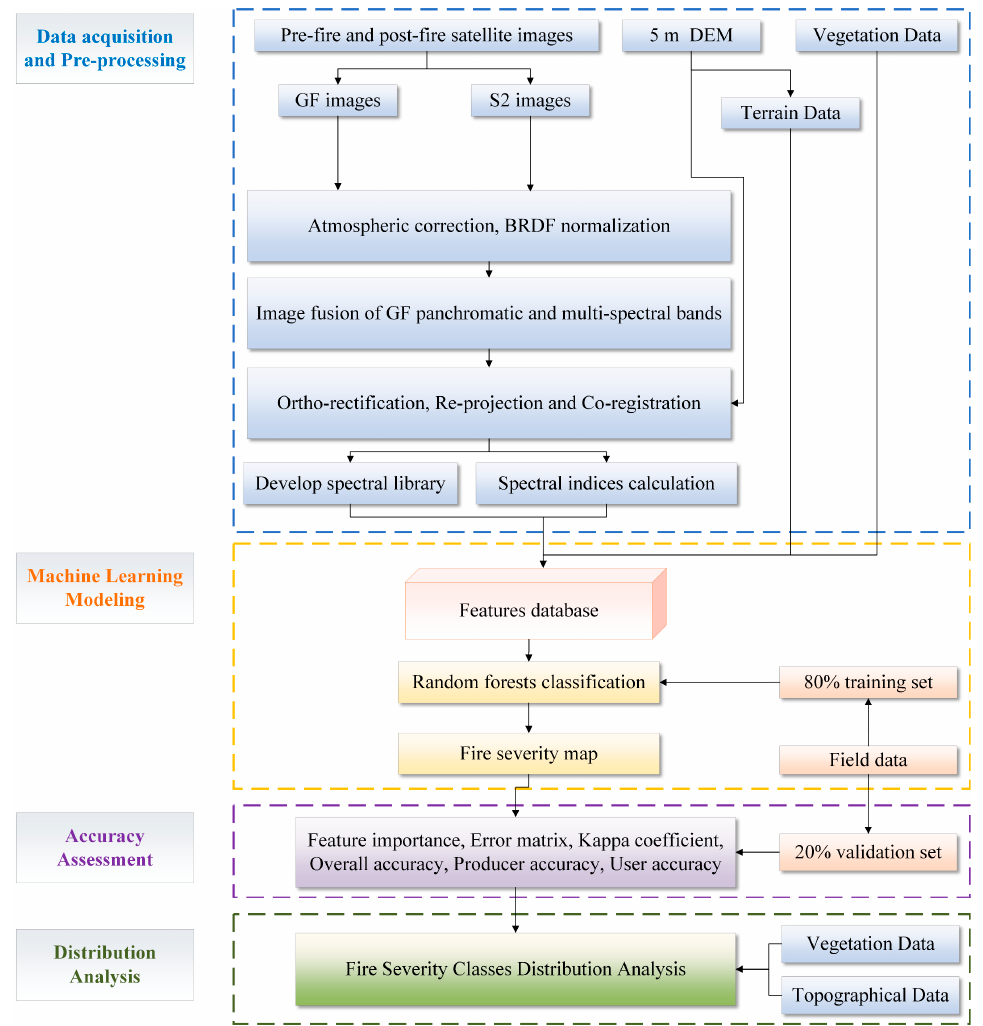
Figure 2. Flowchart of the methodology.